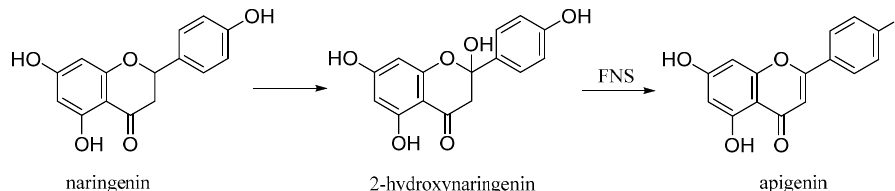
Figure 11. Biosynthetic pathway of apigenin .